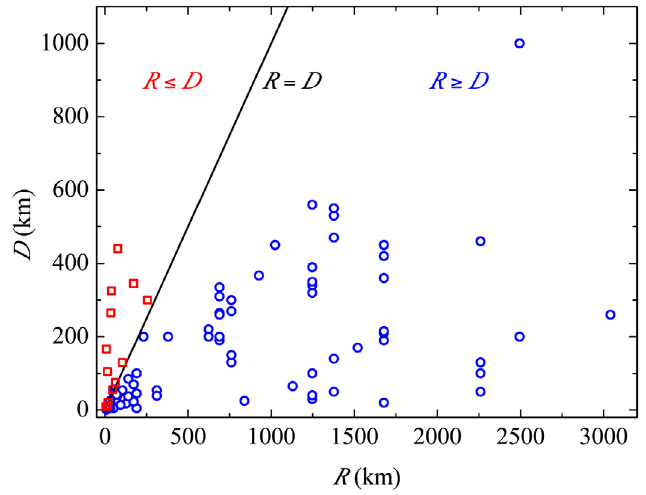
Figure 1. Representation of all radon data points from Toutain and Baubron [1999] in the R-D plane, where R is the earthquake preparation radius, and D the distance (km) from the epicenter to the measuring